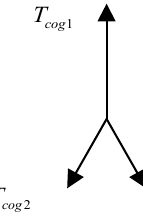
Figure 10. Cogging torque with different tooth pitch by FEM. 4. Design Method for Non-Uniform Tooth Distribution The proposed non-uniform tooth distribution structure introduces additional flux density harmonics by changing the distance between teeth to improve performance. The non-uniform tooth distribution structure divides all teeth into several units for the desired harmonics, while the number of units are designed based on the series poles of PMVM and the winding type. Considering the basic principle of PMVM, the net torque comes from the interaction of corresponding orders flux density of magnets and MMF of wind- ing [1]. The net torque could be expressed as = T